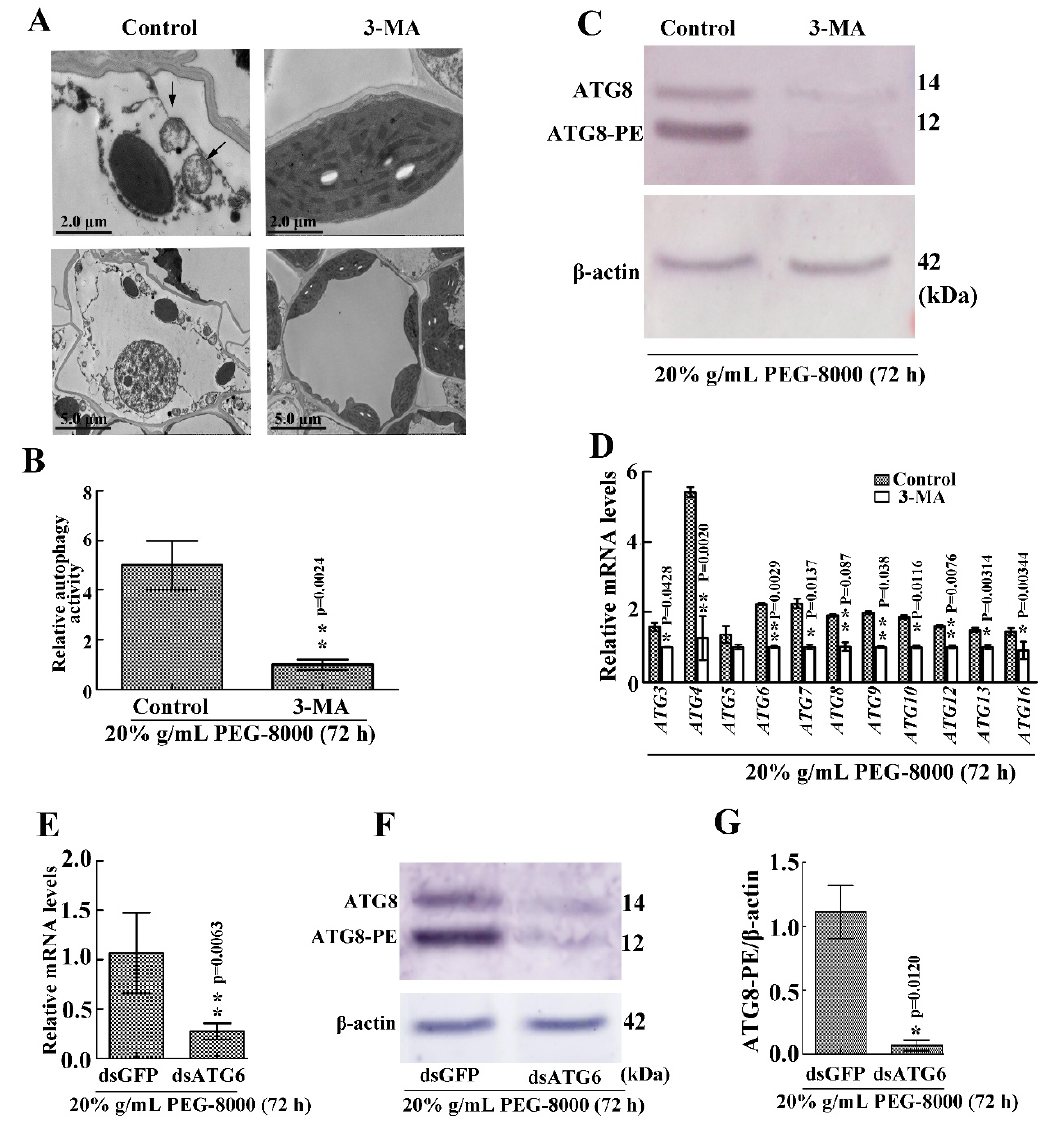
Figure 7. E ff ect of 3-MA and the knockdown of ATG6 on PEG-8000-induced autophagy in wheat seedlings. ( A ) Representative ultrastructure of autophagic bodies (arrows) in the leaves following treatment with 5 mM 3-MA in 20% PEG-8000 for 72 h. As a control, water, instead of 3-MA, was used. ( B ) Relative autophagic activity in PEG-8000-treated plants was normalized to that of the 3-MA-treated plants. Approximately 10 cells were used to quantify autophagic structures per treatment. Bars represent the mean ± SD of three independent experiments. ** indicates a significant di ff erence at p < 0.01 according to Students t -test. Scale bars = 2 µ m (upper images) and 5 µ m (bottom images). ( C ) Western blot assay of ATG8 protein in the leaves following treatment with 3-MA in 20% PEG-8000 for 72 h. β -actin was used as a standard. ( D ) Leaf mRNA levels of autophagy-related genes ( ATG3 , 4 , 5 , 6 , 7 , 8 , 9 , 10 , 12 , 13 , and 16 ) following 3-MA treatment. α -Tubulin was used as the internal reference, and the relative expression was calculated using the 2 − ∆∆ T method. ( E ) qRT-PCR analysis of the knockdown e ffi ciency of ATG6 . α -Tubulin was used as the internal reference, and the relative expression was calculated using the 2 − ∆∆ T method. ( F ) Level of ATG8-PE in the leaves after ATG6 knockdown. ( G ) Statistical analysis of the e ff ects of ATG6 RNAi on ATG8-PE formation. Bars represent the mean ± SD of three independent experiments. * and ** indicate significant di ff erences at p < 0.05 and p < 0.01, respectively, according to Student’s t -test.